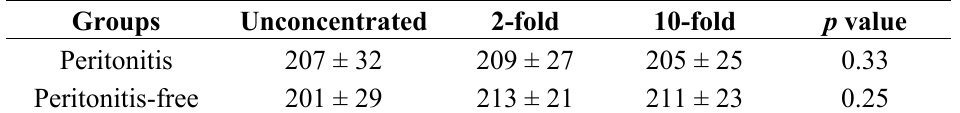
Table 2. Protein profiles obtained with various concentrations of PDE samples using IMAC-Cu beads.